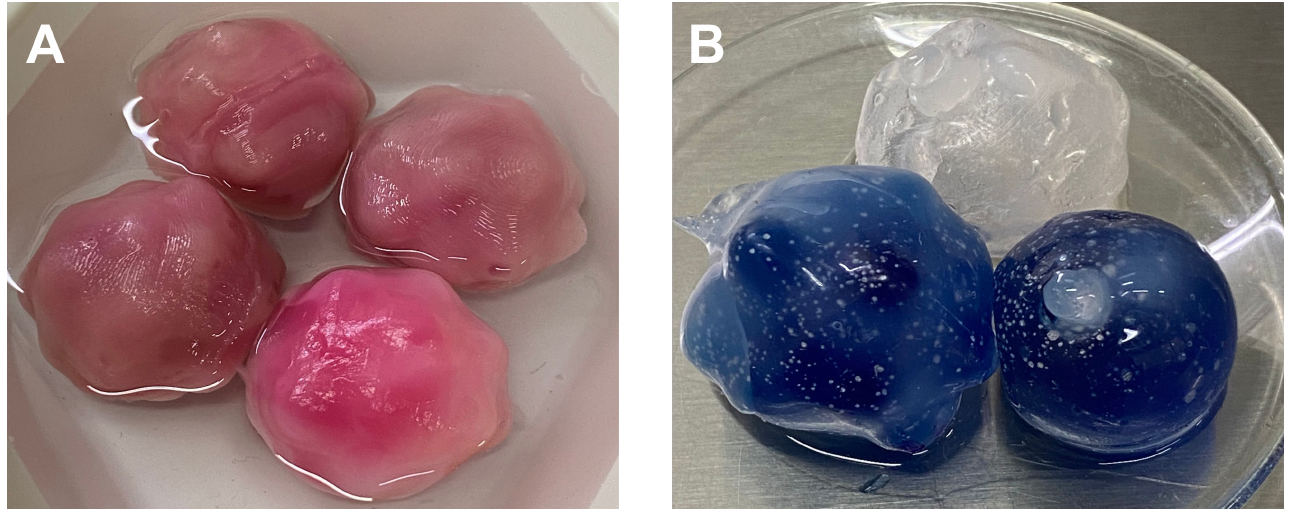
Figure 1. The fabricated inclusions before being embedded into the PVA-C block mimicking the healthy parenchyma. ( A ) PVA-C solid inclusions with irregular shape and color coded. ( B ) Gaseous (transparent) and liquid (blue) inclusions with irregular and spherical shapes fabricated with